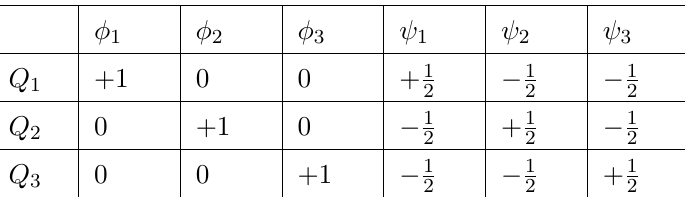
Table 4 . Charges of scalar and fermionic (cid:12)elds under the Cartan charges of R-symmetry SU(4). These charges generate the symmetry group U(1) (cid:10) U(1) (cid:10) U(1) left over after the breaking of R -symmetry by